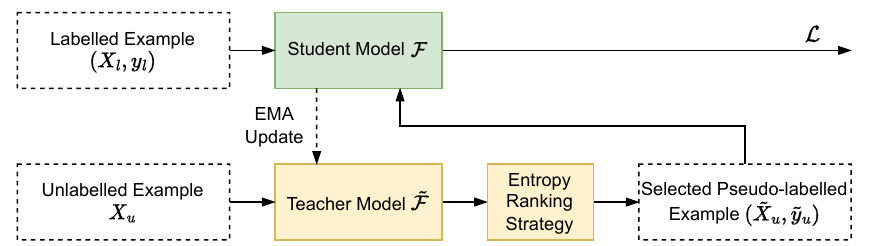
Figure 4. Our learning framework for dealing with the semi-supervised learning and domain adaptation settings. We use the semi-supervised learning setting as an example in this figure. We first produce pseudo-labels for the unlabelled example X u entropy ranking strategy to obtain the pseudo-labelled point cloud example ( ˜X u contains the selected points and their corresponding pseudo-labels. During the training process, we update the student model F by training on both the labelled and pseudo-labelled examples, while we update the teacher model ˜ F by taking the EMA of the student model. We use only the student model during